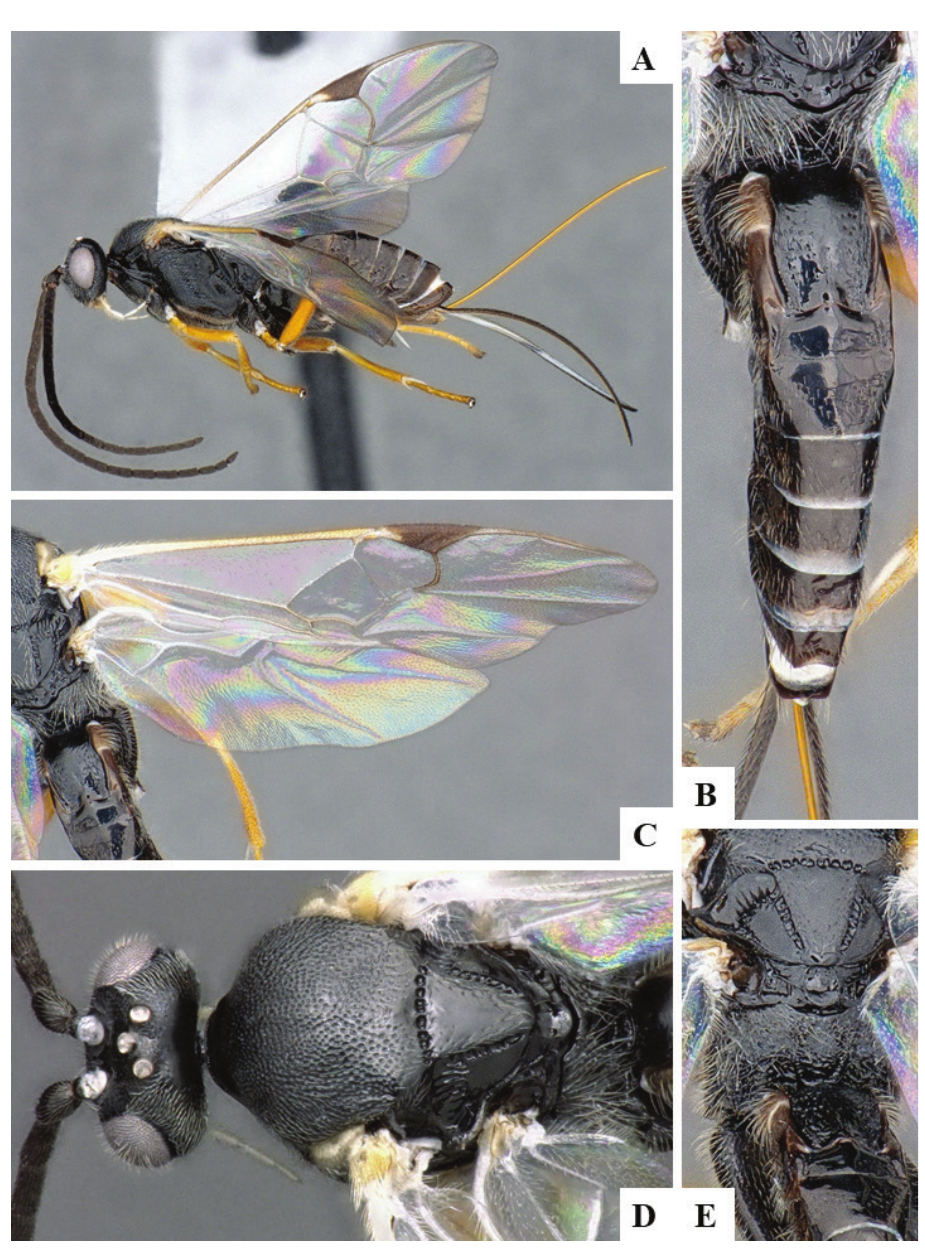
Figure 3. A–E Dolichogenidea carlosmanuelrodriguezi sp. n., holotype. A habitus, lateral B metasoma, dorsal C wings D head and mesosoma, dorsal E details of scutellar complex, propodeum and